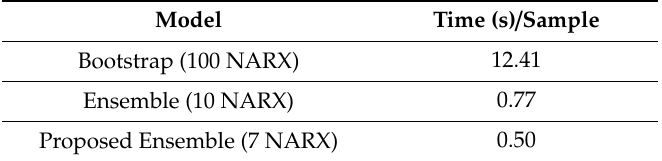
Table 3. A comparison of nowcasting execution time of proposed model vs.